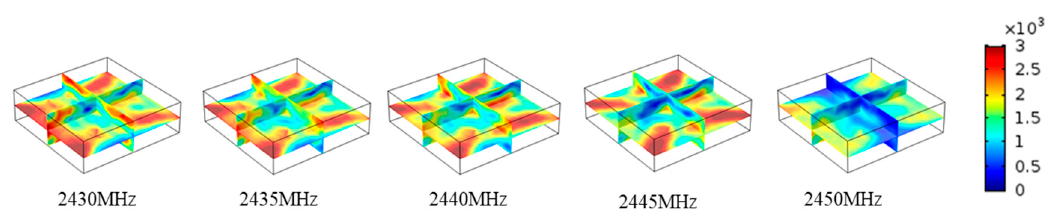
Figure 9. The electric field distribution at di ff erent frequencies.